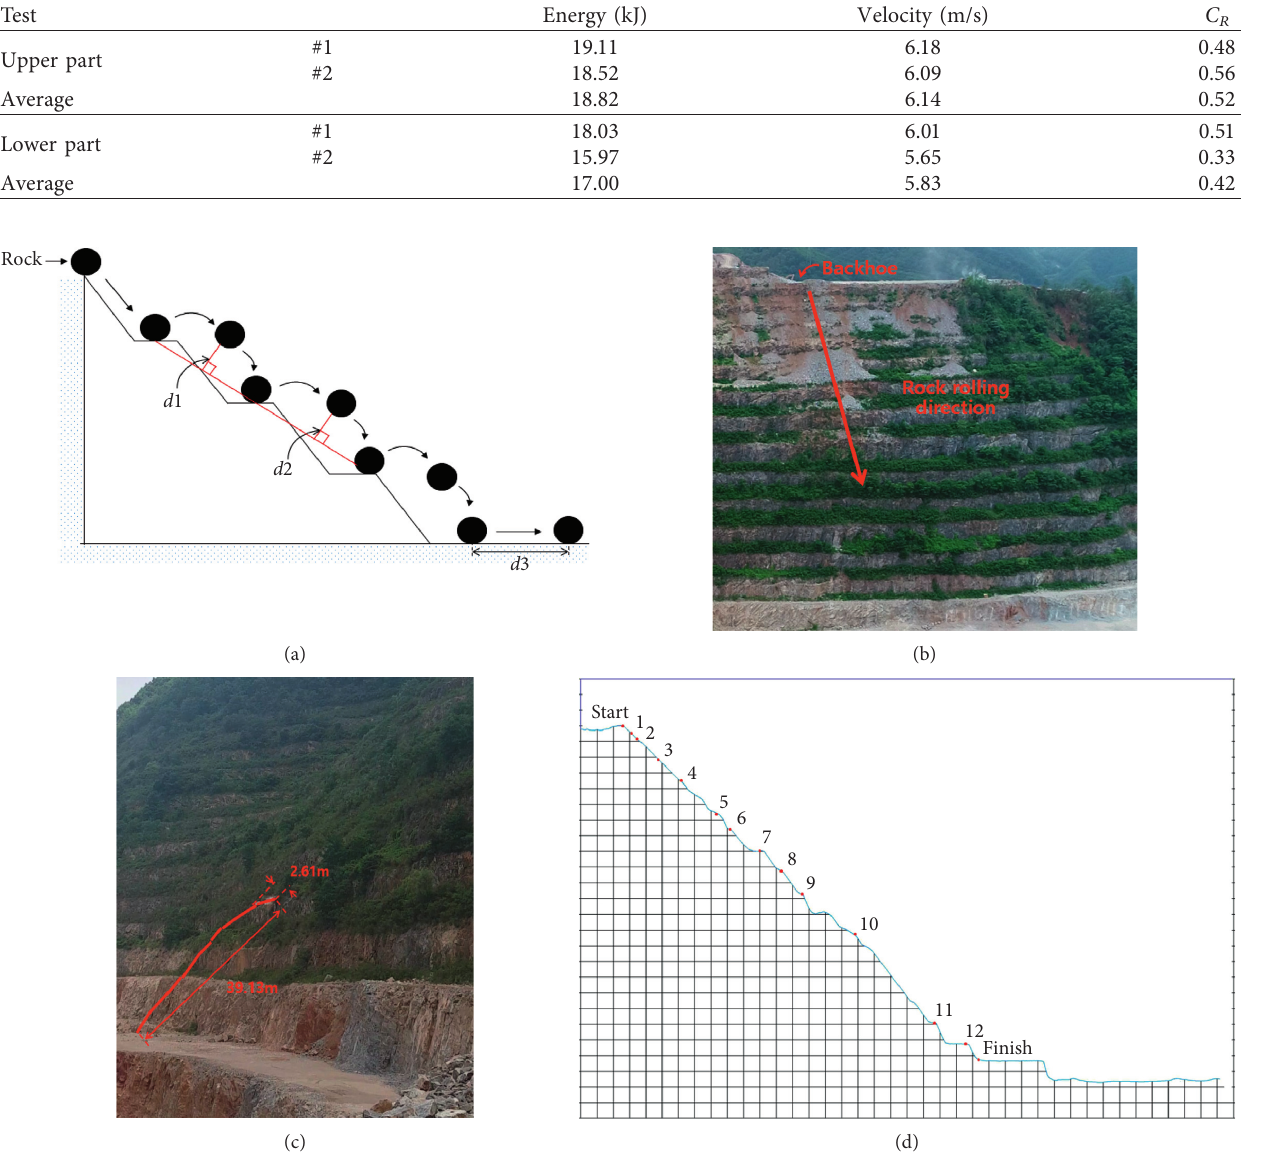
Figure 3: Rock-dropping test: (a) measurement scheme; (b) dropping direction; (c) height measurement; (d) touching